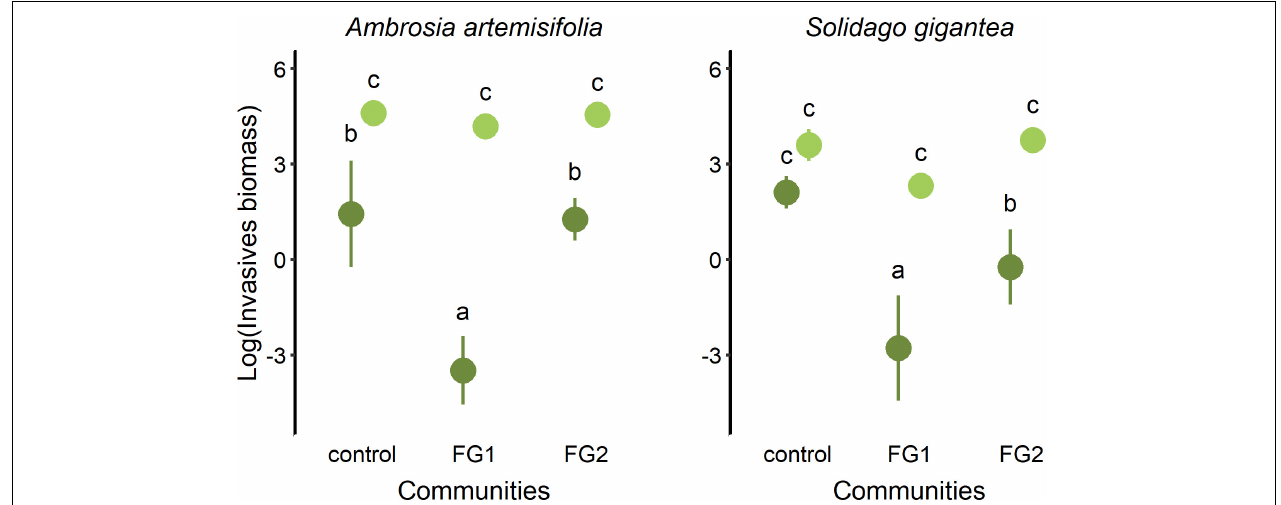
FIGURE 1 | Effect of the community type and time of arrival on biomass of the invasive alien Ambrosia artemisiifolia and Solidago gigantea 8 weeks after sowing (control, monoculture of the invasive plant species; FG1, functional group 1; FG2, functional group 2). Light green symbols indicate simultaneous seeding of native and invasive species, and dark green symbols show results for late arrival of invasive species. ANOVA: interaction F A . artemisiifolia = 19.4, P < 0.001; F S . gigantea = 10.6, P < 0.001; letters indicate significant differences among treatments ( P < 0.05).